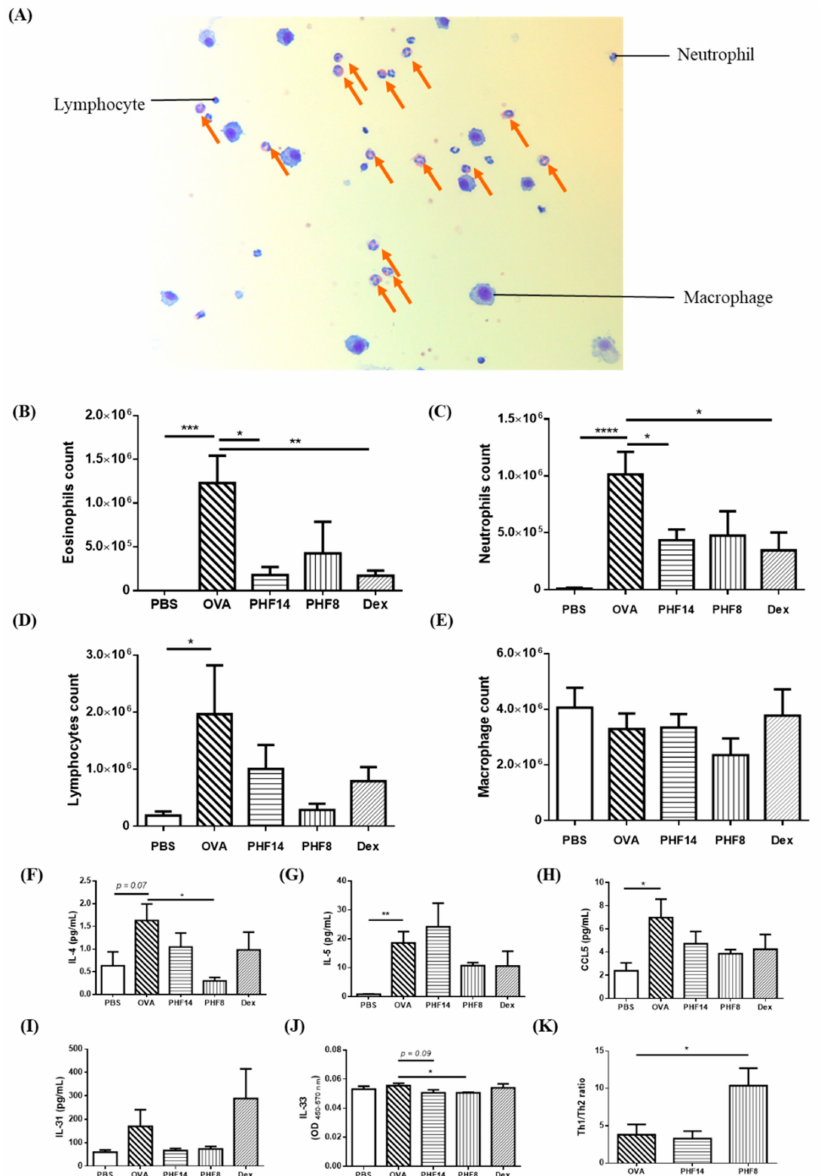
Figure 2. Effects of oral treatment of PHF on the leucocytes, cytokines and chemokines in bronchoalveolar lavage (BAL) of the allergic asthmatic mice. ( A ) Representative eosinophils and other leucocytes in the BAL fluid stained with Shandon Rapid-Chrome Kwik Diff Staining kit (200 × ). Orange arrows depict the eosinophils presented in the BAL fluid. ( B – E ) The total number of eosinophils, neutrophils, lymphocytes, and macrophages were counted and presented in bar charts with means + SEM ( n = 4–8). ( F – H ) The level of IL-4, IL-5 and CCL5 released in the BAL fluid of the mice was measured by Bio-plex pro assay. Results are shown in bar charts with mean + SEM ( n = 5–8). ( I , J ) The level of IL-31 and IL-33 released in the BAL fluid of the mice was measured by enzyme-linked immunosorbent assay (ELISA). Results are shown in bar charts with concentration or O.D. mean + SEM ( n = 5–8). ( K ) Th1/Th2 ratio, as calculated by dividing the level of Th1 cytokine IFN- γ by Th2 cytokine IL-4 in BAL fluid, was shown in bar chats with mean + SEM ( n = 5–8). * p < 0.05, ** p < 0.01, *** p < 0.001, **** p < 0.0001 when compared with the OVA control group. PBS: healthy control; OVA: OVA-induced allergic asthmatic control; PHF14: mice with 14-day PHF treatment; PHF8: mice with 8-day PHF treatment; Dex: dexamethasone positive